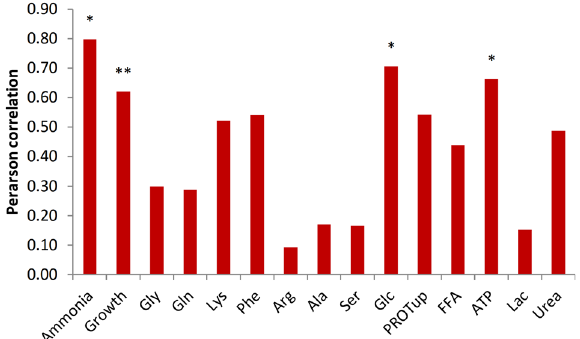
Fig. 1 Ammonia transport is the best objective in metabolic modeling of a healthy kidney. Correlation coef fi cients between measured fl uxes in the AL group and predicted values using structural fl uxes. The asterisk * indicates a signi fi cant correlation between predictions and measurements ( P < 0.05), **0.05 < P <